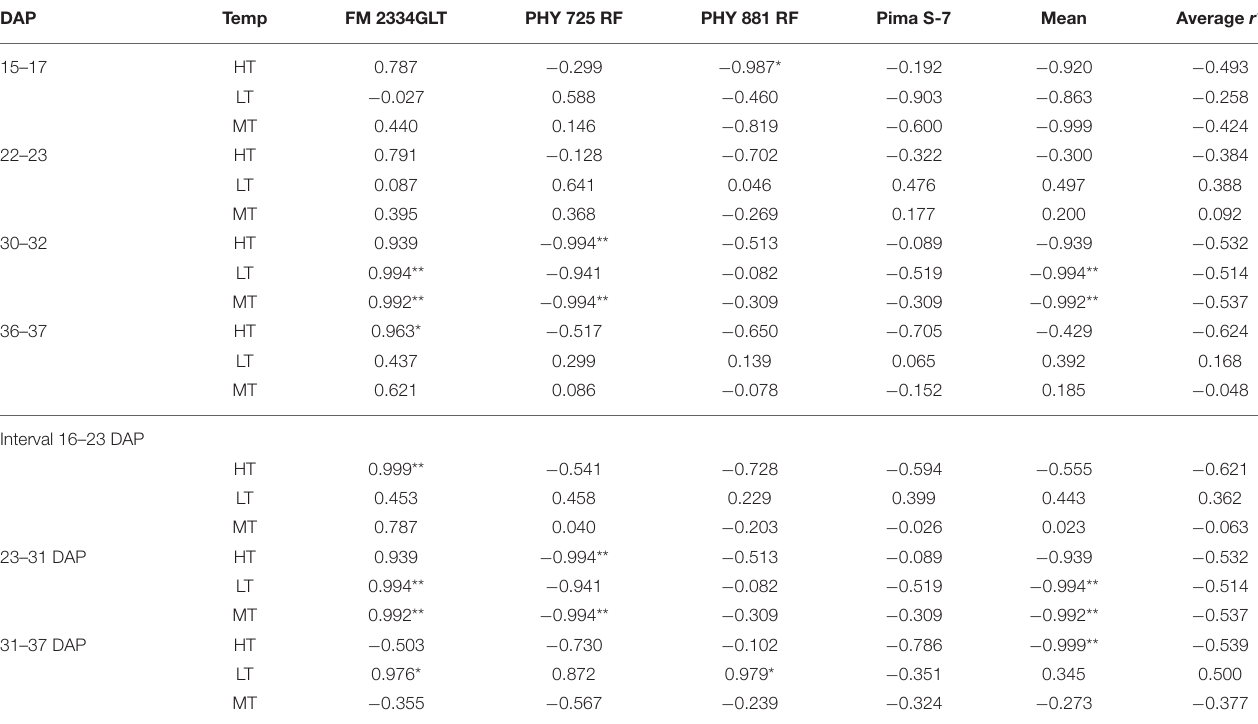
TABLE 2 | Coefficients of correlation ( r ) between mortality caused by Fusarium wilt race 4 ( Fusarium oxysporum f. sp. vasinfectum ) and average daily high (HT), low (LT), and mean (MT) temperatures (Temp) at different days after planting (DAP) from three planting dates (5/7, 5/26, and 6/17) in 2021. DAP Temp FM 2334GLT